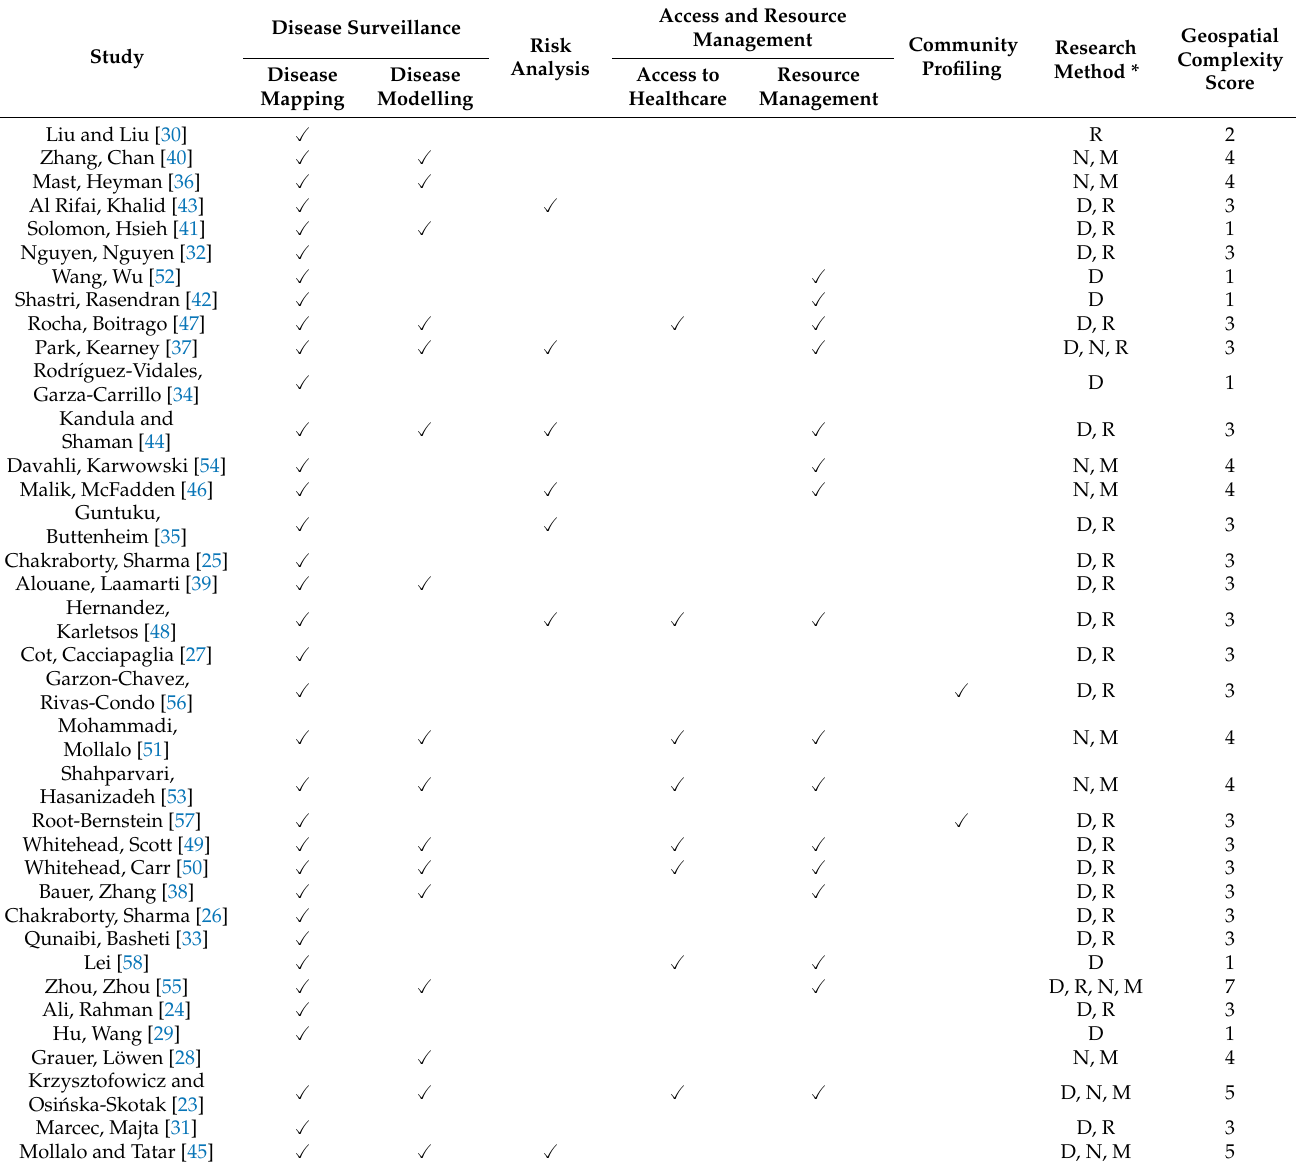
Table 2. Characteristics of the included